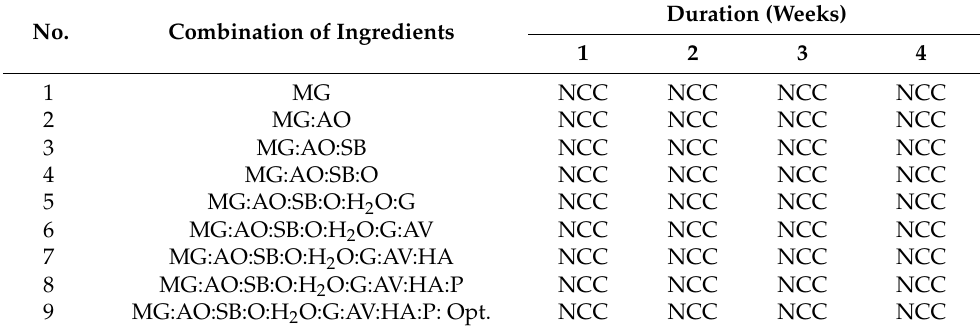
Table 2. Physical compatibility of mangosteen peel extract and excipients.